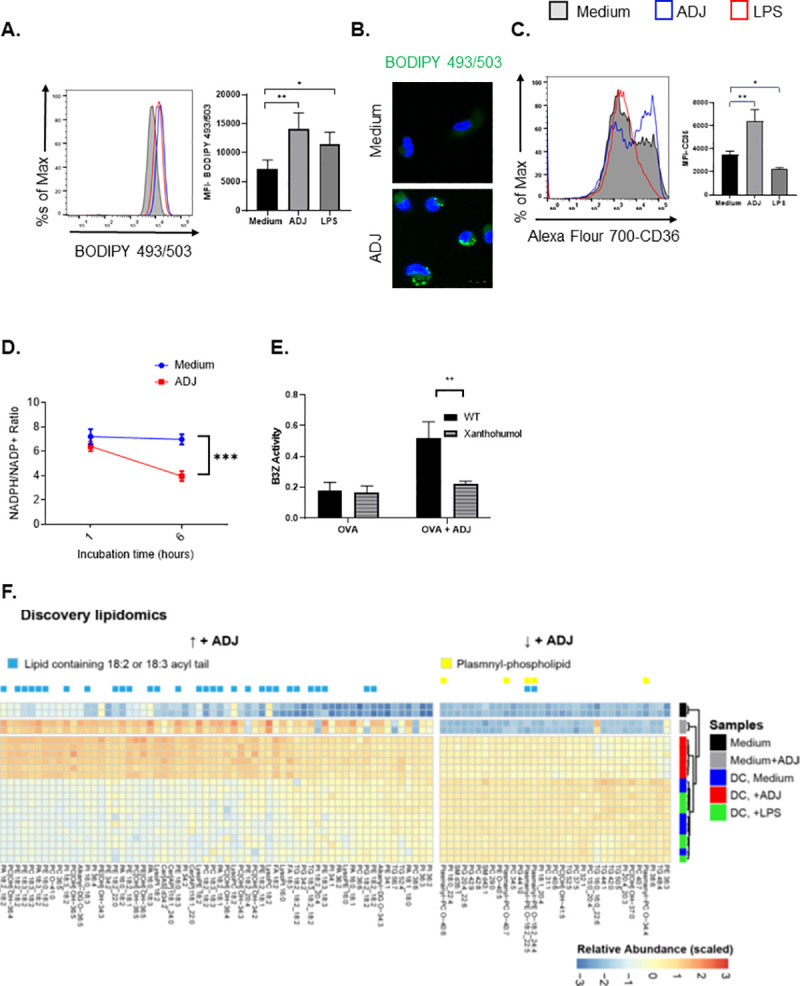
Carbomer-based adjuvant induces intracellular lipid body formation and alters intracellular lipidomes in DCs.(A) Quantification of neutral lipid droplets by flow cytometry using BODIPY 493/503 dye. BMDCs treated with ADJ (1%) for 24 h were stained with BODIPY 493/503 dye and analyzed by flow cytometry (B) Confocal microscopy of DCs were cultured with ADJ (1%) for 24 h, stained with BODIPY 493/503, and counter-stained with DAPI. Scale bars, 10 μm. (C) FACS analysis of CD36 expression in unstimulated, and ADJ- or LPS-stimulated DCs after 24 h. (D) NADPH/NADH+ ratio in resting, ADJ- or LPS-stimulated DCs. (E) β-galactosidase production by B3Z cells after co-culture with BMDCs pre-treated with OVA ± ADJ in the presence/absence of xanthohumol for 5 h. (F) Heat-map of lipids from media or DCs stimulated with ADJ ± LPS; P < 0.05 (ANOVA for +ADJ treatment, Tukey post-hoc corrected p-values) and abundance was scaled across samples. Lipids that increased with ADJ treatment were enriched for 18:2 or 18:3 acyl-chains (blue bar). Lipids that were decreased with ADJ treatment contained more plasmanyl-phospholipids (yellow bar). Abbreviations: TG, triglyceride; DG, diglyceride; FA, fatty acid; PA, phosphatidic acid; PC, phosphatidylcholine; PE, phosphatidylethanolamine; PG, phosphatidylglycerol; PI, phosphatidylinositol; SM, sphingomyelin; Cer [AP], alpha-OH fatty acids with pytosphingosine; Cer [AS], alpha-OH fatty acids with sphingosine. Data are representative of 2 independent experiments. Error bars show SEM; *P<0.01; **P<0.001; ***P<0.0001 (One-way ANOVA- A, C; Student’s t-test- D-E).